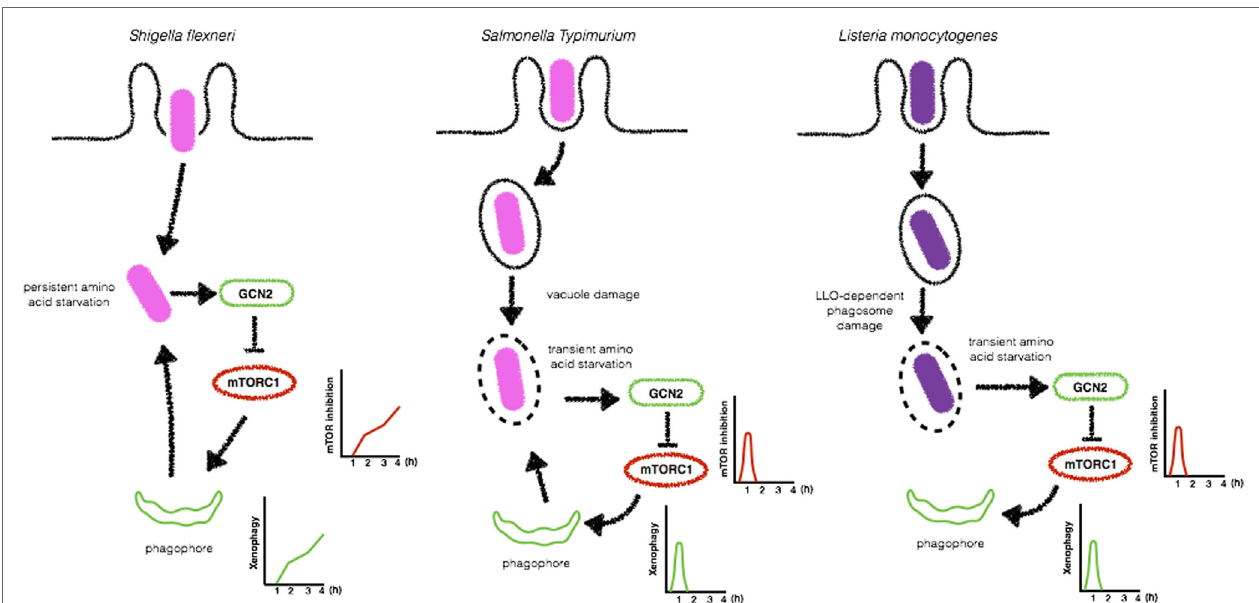
FigURe 7 | Bacteria-induced amino acid starvation stress triggers xenophagy. Shigella flexneri induces a persistent amino acid starvation that leads to GCN2 activation and inhibition of mTORC1 to allow the formation of bacteria targeted autophagosomes (left). In contrast, Salmonella Typhimurium (center) and Listeria monocytogenes (right) trigger only a transient amino acid starvation and inhibition of mTORC1, allowing its reactivation at later time-points to block the formation of